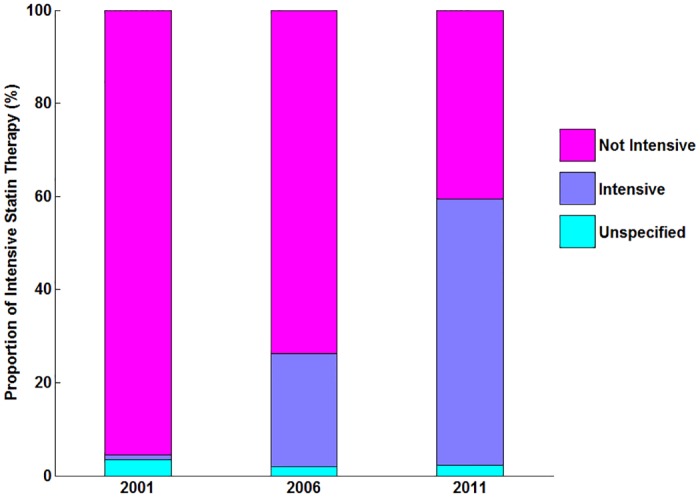
Statin Intensity Therapy among Patients with Statin Therapy in China.P for trend <0.001 for the proportion of intensive statin therapy in 2001, 2006 and 2011. WR indicates Western rural; CR indicates Central rural; ER indicates Eastern rural; C/WU indicates Central/Western urban; EU indicates Eastern urban.